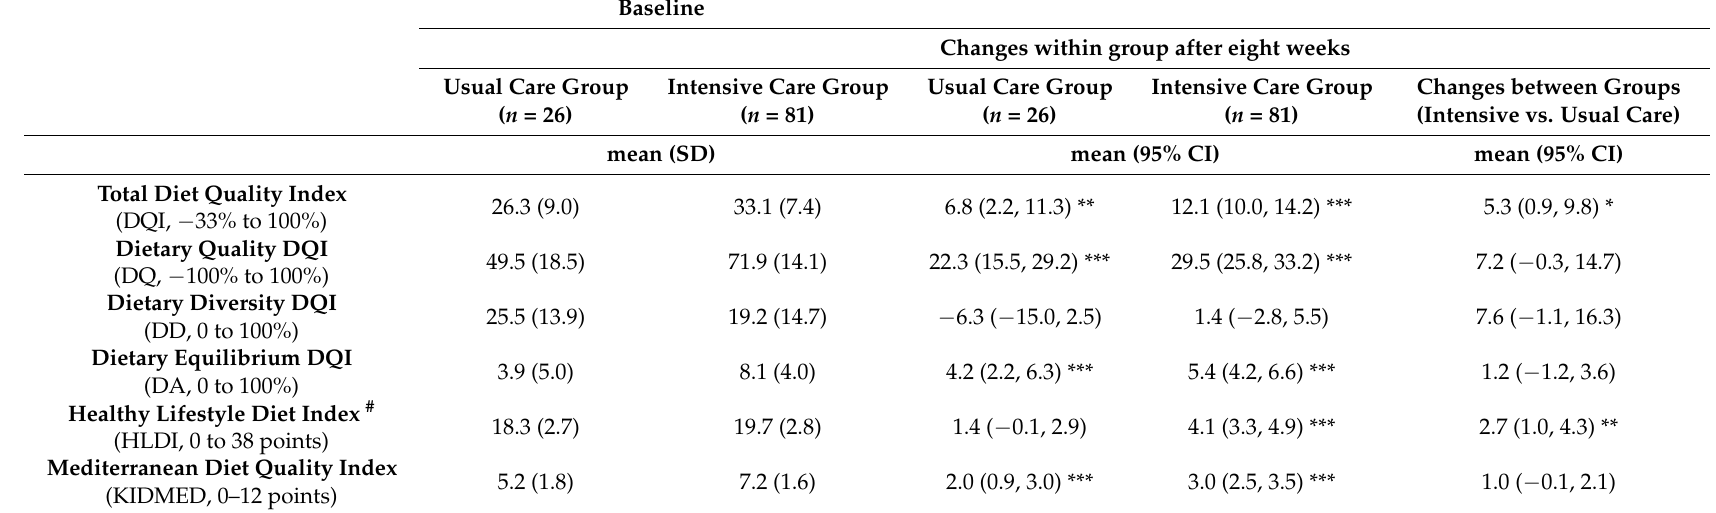
Table 5. Change in diet quality indices after lifestyle intervention in children with abdominal obesity.